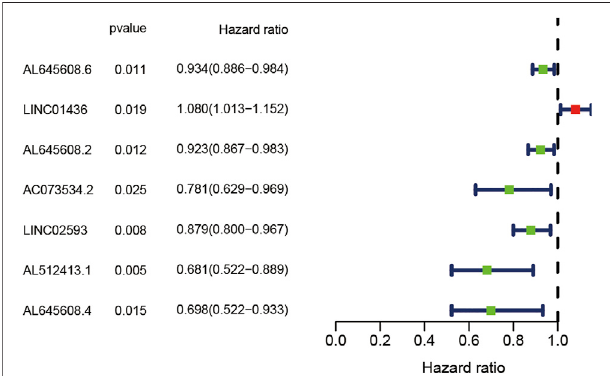
FIGURE2| ForestplotoftheunivariateCoxregressionanalysisofseven lncRNAs with prognostic value. The X -axis represents the risk ratio, and the Y -axis represents the lncRNAs with prognostic value. Red represents a high- risk factor, which is negatively correlated with the survival time of the patient. Blue represents a low-risk factor, which is positively correlated with the survival time of the